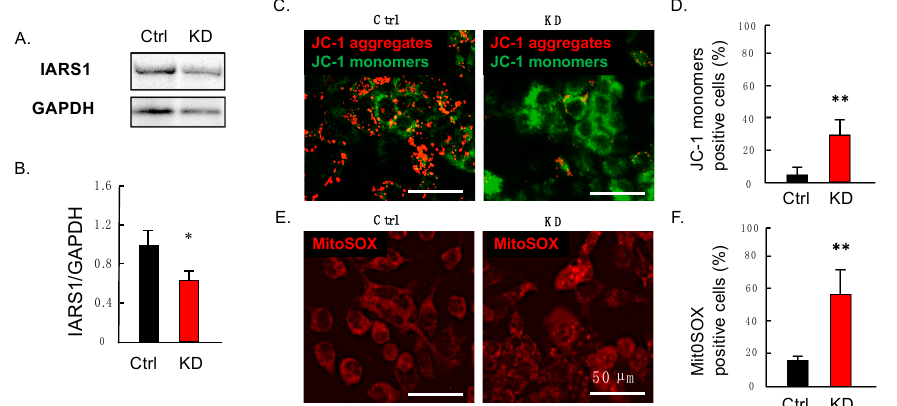
Figure 3. Analysis of IARS1 mitochondrial function in vitro. ( A , B ) Western blotting showed signif- icant reductions in IARS1 protein levels in HepG2 cells after transfection with IARS siRNA ( n = 3). ( C , D ) IARS1 knockdown (IARS1-KD) cells showed a decrease in mitochondrial membrane potential ( n = 3) and ( E , F ) an increase in mitochondrial superoxide radicals; * denotes p < 0.05. ** denotes p < 0.01.